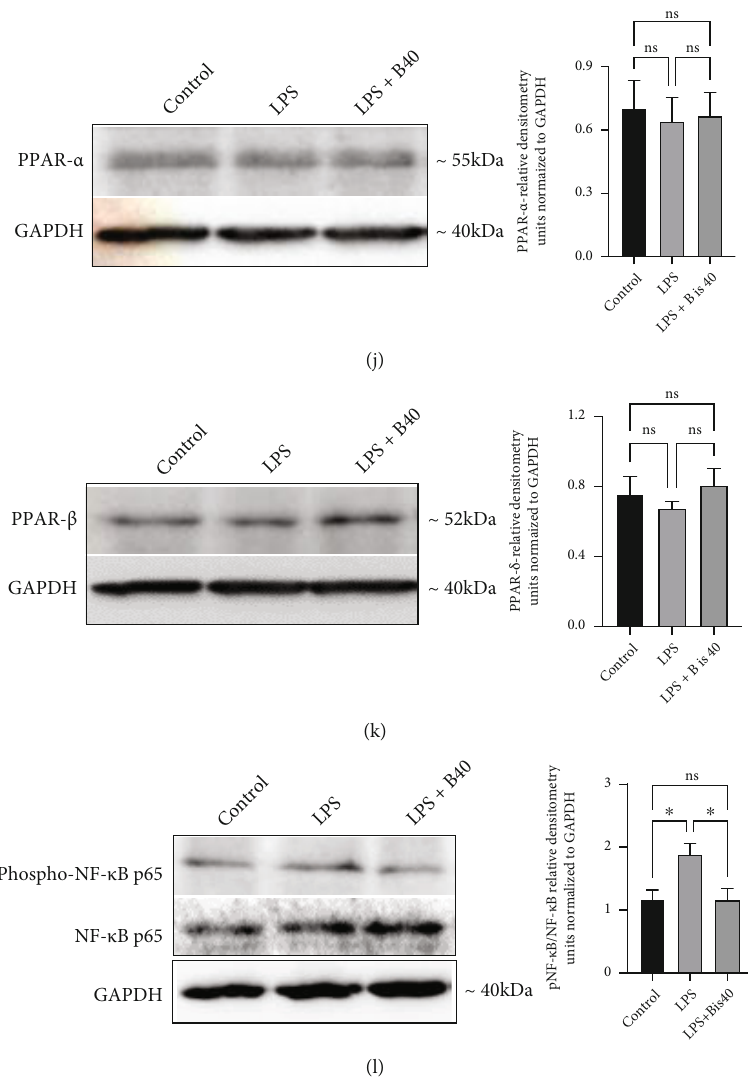
Figure 6: E ff ect of bisabolol pretreatment on LPS-stimulated RAW264.7 macrophage viability, proin fl ammatory cytokine response, PPAR- γ , PPAR- α , PPAR- β , and protein expression. Bisabolol treatment did not a ff ect RAW264.7 cell viability at 24 h and 48 h (a, b). RAW cells were pretreated with bisabolol for 6hr, subsequently stimulated with LPS for 24 hr. Bisabolol pretreatment signi fi cantly reduced proin fl ammatory cytokine response at protein (IL-6 (c), IL-1 β (d), and TNF- α (e)) and mRNA levels (IL-6 (f), IL-1 β (g), and TNF- α (h)). Bisabolol pretreatment signi fi cantly increased PPAR- γ protein expression (i),\ but did not a ff ect PPAR- α (j) and PPAR- β (k) protein expression. Bisabolol pretreatment signi fi cantly prevented the increase in the phosphorylation of pNF- κ B p65 protein (l). The density of immunoblots was normalized to GAPDH. Five ( n = 5 ) di ff erent experiments were run for Western blot and mRNA measurements. The data expressed as mean ± SEM . ∗ p < 0 : 05 , ∗∗ p < 0 : 01 , and ∗∗∗ p < 0 : 001 . ns: not signi fi